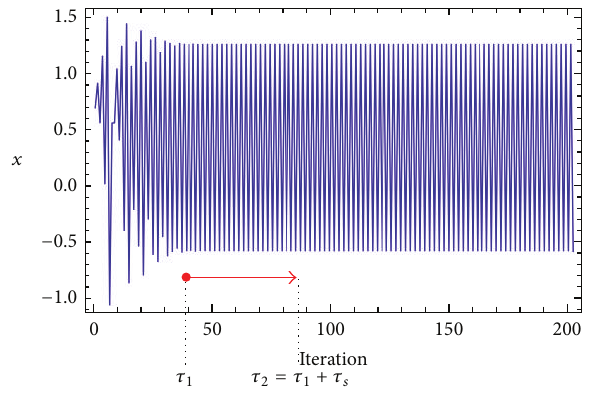
Figure 10: “Floating window” for minimization.